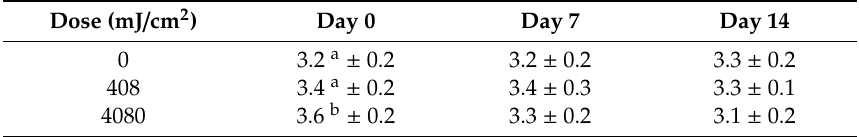
Table 7. Mean and standard error values of the antioxidant capacities of rolled fillets of ham depending on the UV-C dose and storage day ( n =